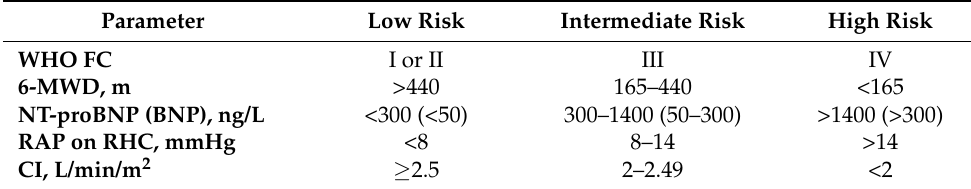
Table A1. Cutoffs of Clinical and Hemodynamic Parameters Used for Risk Stratification.